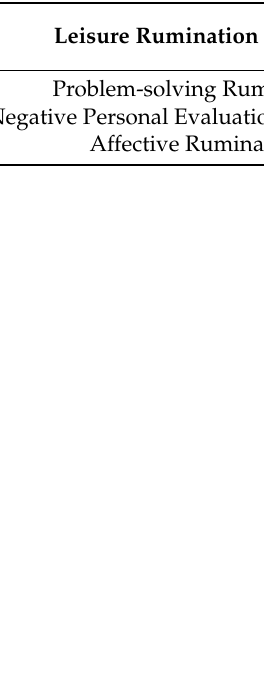
Table 2. Reliability and Validity of the Leisure Rumination Scale.